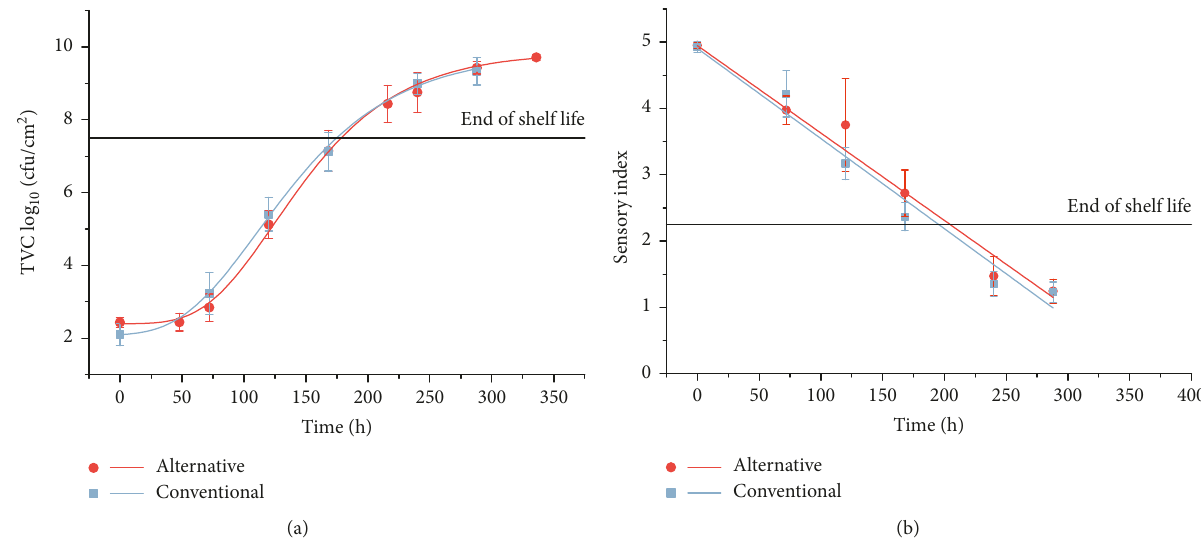
Figure 3: Shelf life of alternative and conventional produced poultry filets determined by microbiological contamination (a) and sensory index (b).